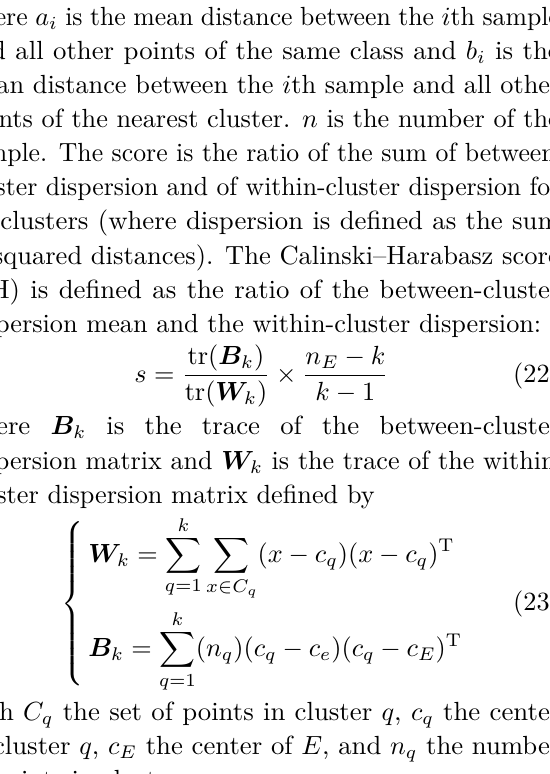
Fig. 3 Fitting results of BFM17 [14], FLAME [13], and ours. The first row is the fitted mesh and the second row is the error map with ground truth. SFM* is the SFM finetuned with 2D data